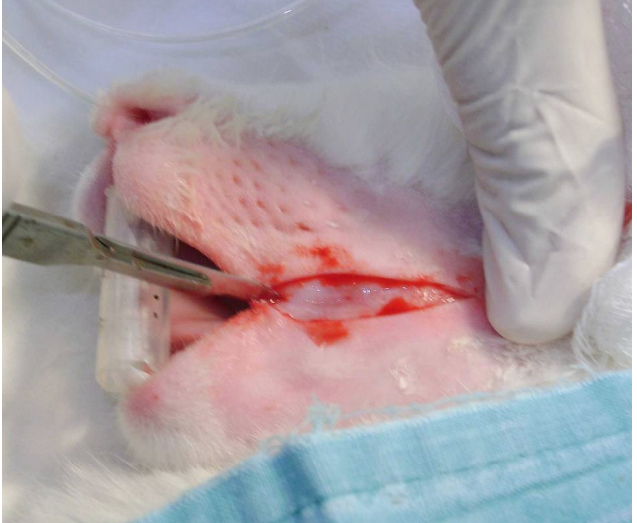
FIGURE 3 – Tooth socket of the first molar.